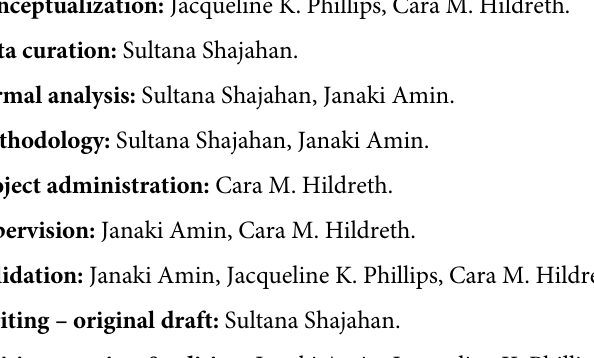
S1 Table. List of excluded studies with reasons for exclusion. S2 Table. Risk of bias summary for individual